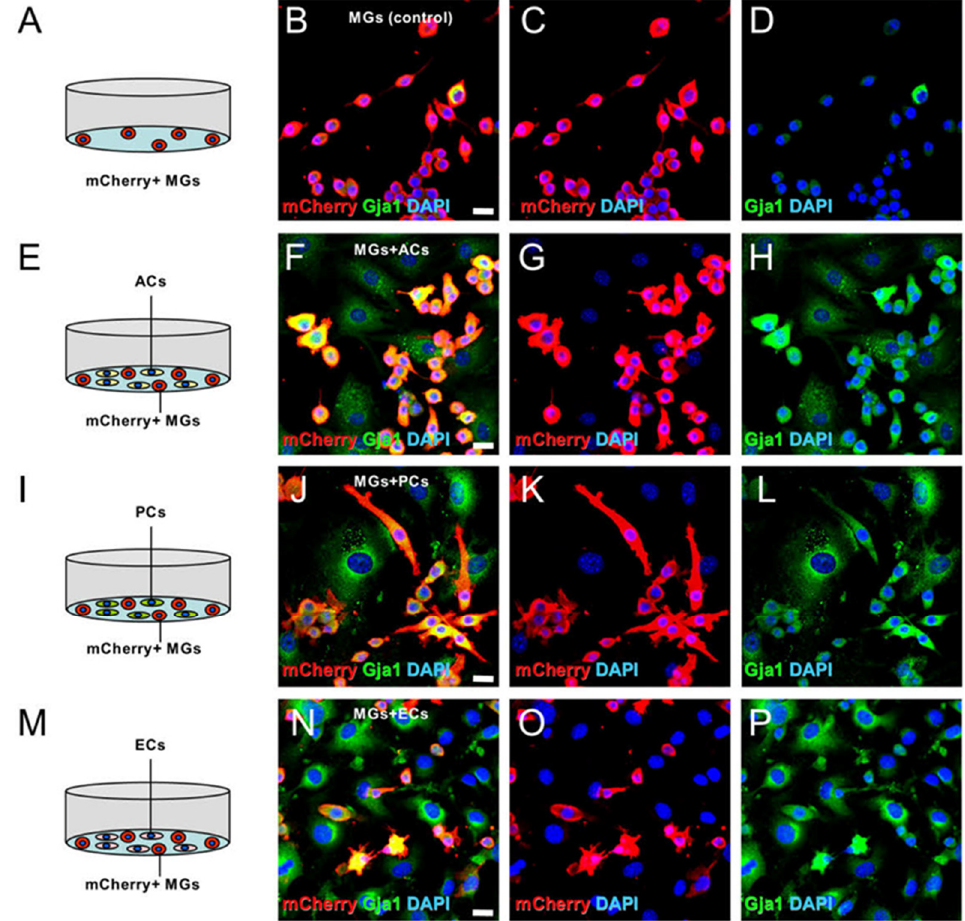
Figure 7. Immunohistochemical staining for Gja1 expression in MGs cultured alone ( A – D ) or with ACs ( E – H ), PCs ( I – L ), or ECs ( M – P ) (mCherry ( B , C , F , G , J , K , N , O : red); Gja1 ( B , D , F , H , J , L , N , P : green); DAPI ( B – D , F – H , J – L , N – P : blue)). The results represent triplicates. Scale bars: 20 µm ( B , F , J , N ). Abbreviations: AC, astrocyte; DAPI, 4’,6-diamidino-2-phenylindole; EC, endothelial cell; Gja1, gap junction protein, alpha 1; MG, microglial cell; PC, pericyte.